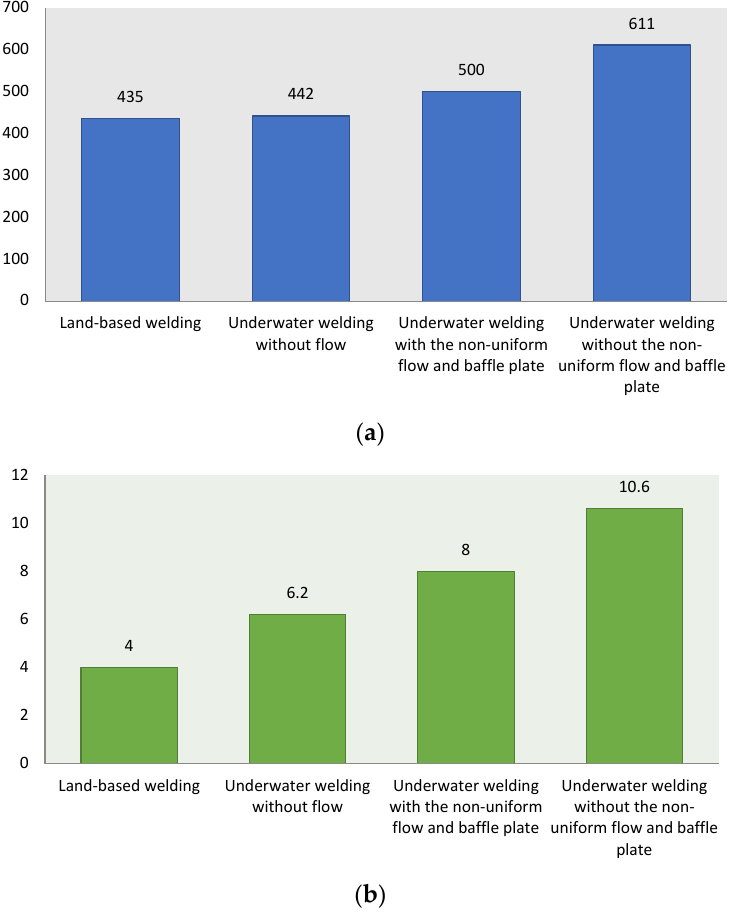
Figure 19. Tensile strength test results for different welding types. ( a ) Tensile Strength (MPa), ( b ) Elongation (%).